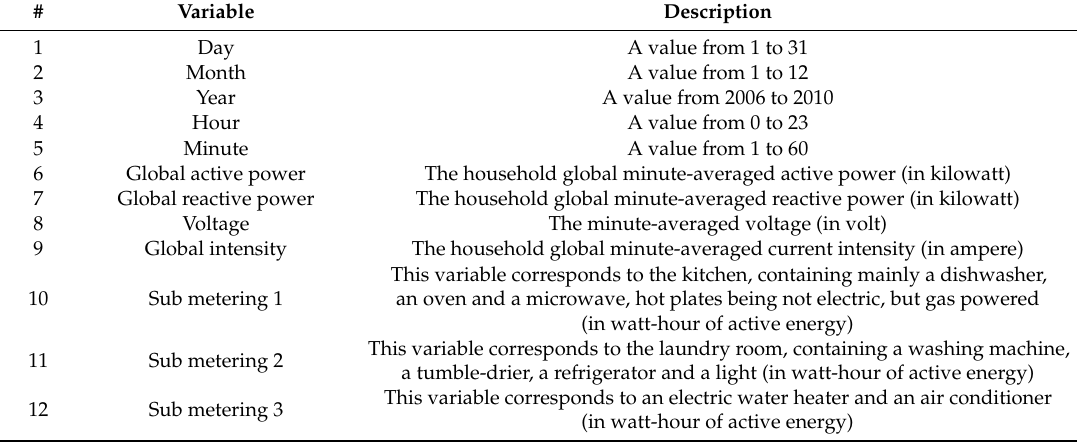
Table 1. The features of the IHEPC